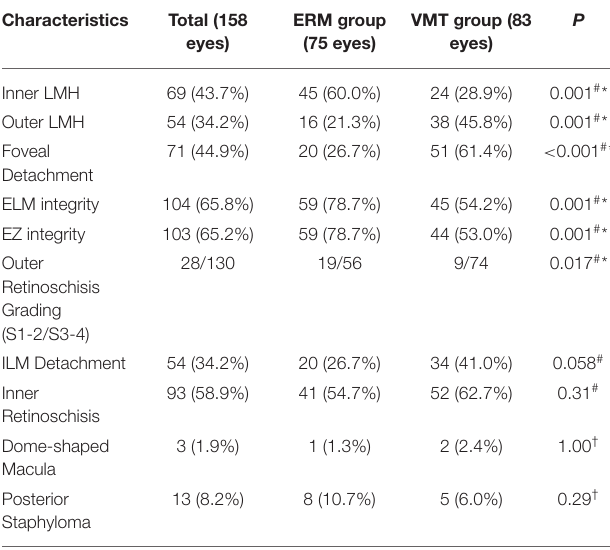
TABLE 2 | Comparation of morphological characteristics between eyes with different vitreomacular interface